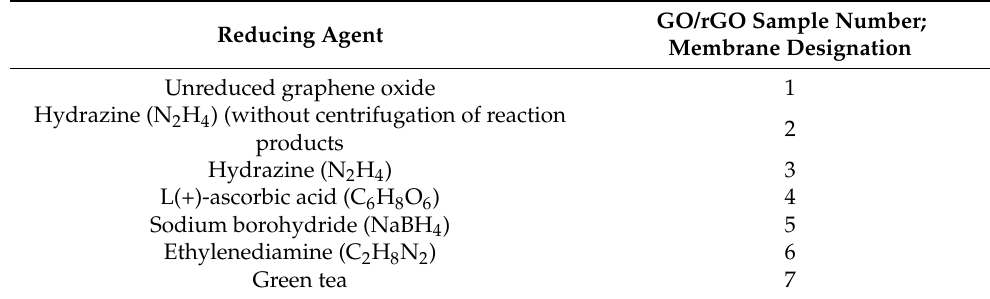
Table 1. Variant of the graphene oxide reducing agent and the corresponding membrane designation. Reducing Agent